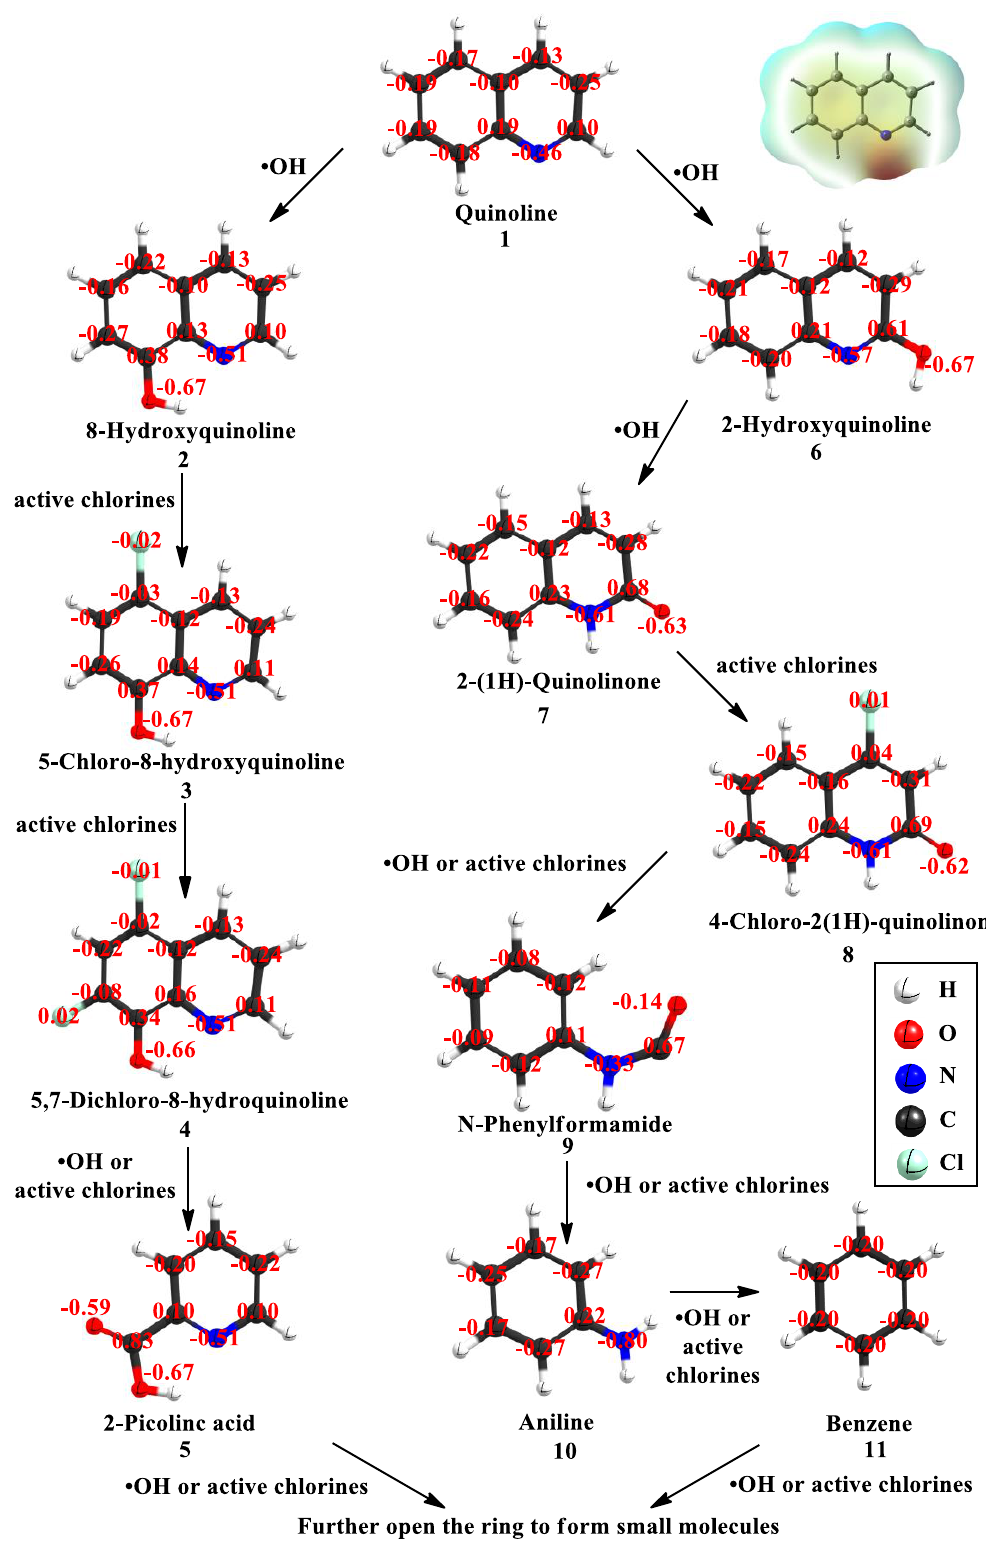
Figure 6. The Natural charge on each atom calculated at the theoretical level of MN15L/6-311G(d) along with two possible degradation pathways of quinoline in E-Fenton system. The electrostatic potential energy surface of quinoline is shown at the upper right corner/inset.